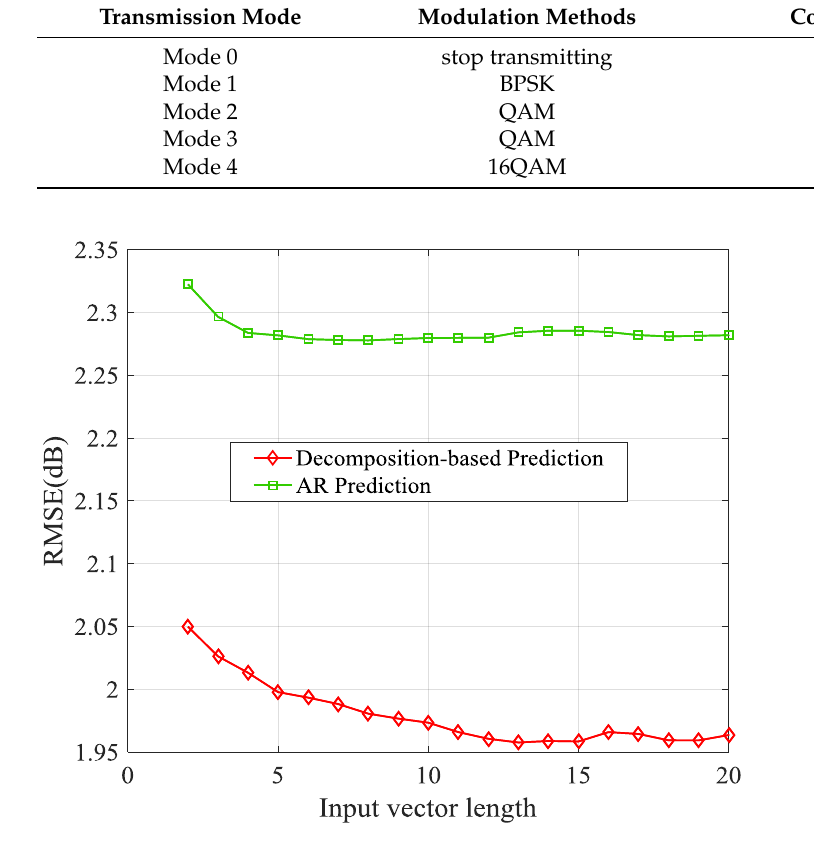
Figure 20. RMSE of small-scale channel state prediction with different input vector length. Table 3. Comparative schemes.